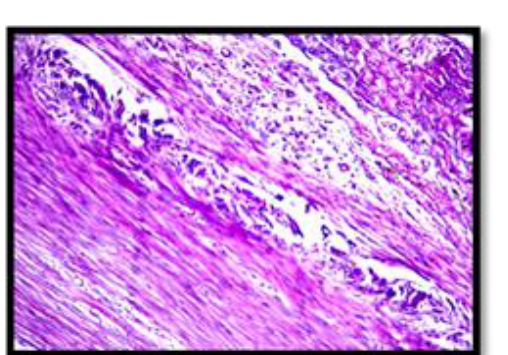
Figure, 8: BP-treatment group at 8th week post implantation, shows presence of thick collagen fibers (long arrow) with moderate vascular granulation tissue (short arrow) (Mallory stain, 200X). The histopathological section at 8 weeks post implantation in BP group showed a fragments of BP and high vascularization, presence of immature collagen fibers and blood vessels (BVs) in the host